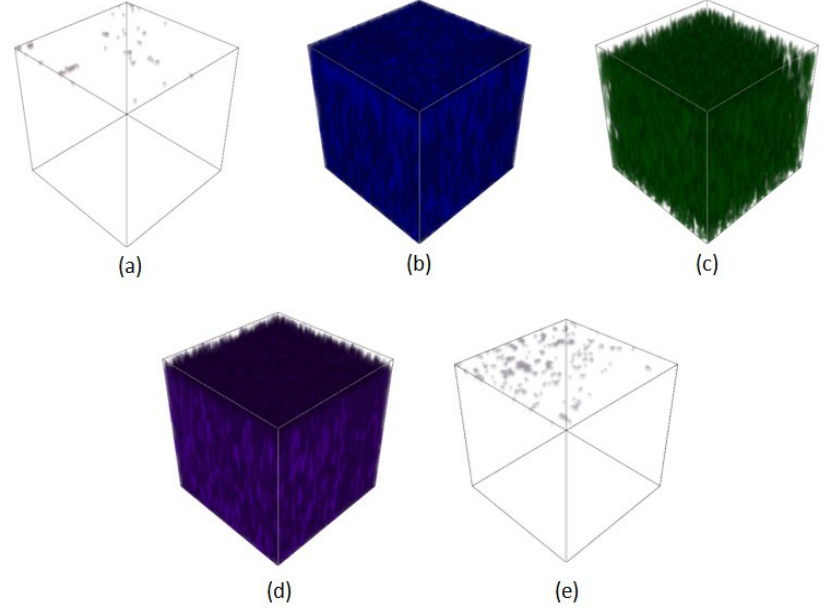
Figure 8. Three-dimensional distributions of ions on the FA surface treated with H 2 SO 4 (1 × 10 −3 mol/L) and oleate (2 × 10 −4 mol/L): ( a ) SO 4− , ( b ) CO 3− , ( c ) CaO − , ( d ) MgO − , and ( e ) C 2 H 3 O 2− .